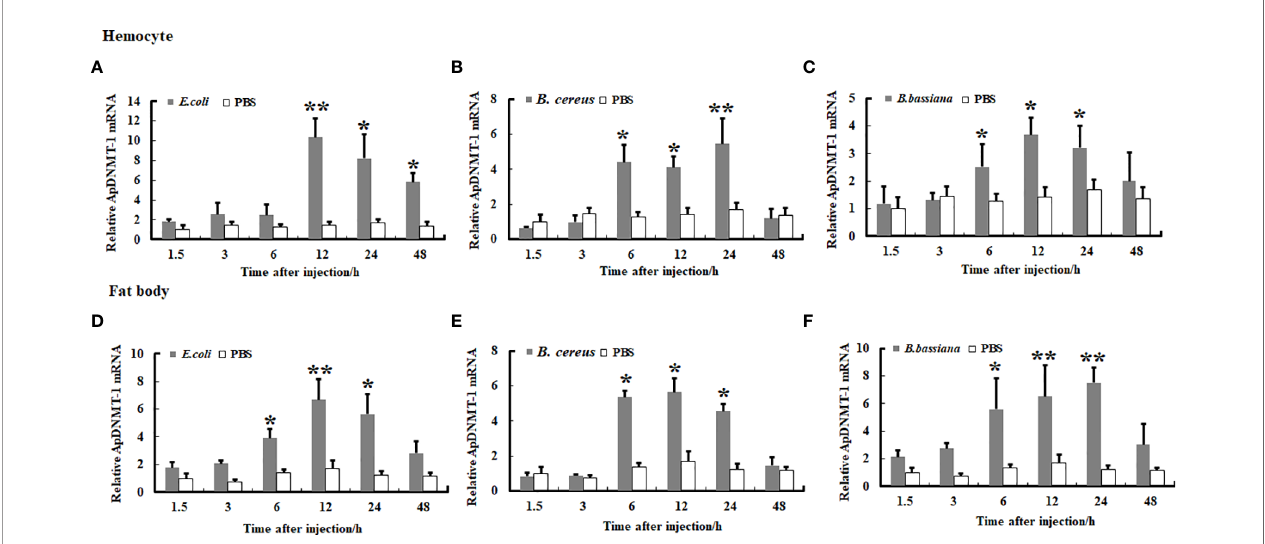
FIGURE 6 | Expression pro fi le of ApDNMT-1 in hemocyte and fat body following microbial challenge. (A) Expression pro fi le following E. coli challenge in hemocyte, (B) Expression pro fi le following B. cereus challenge in hemocyte, (C) Expression pro fi le following B. bassiana challenge in hemocyte, (D) Expression pro fi le following E. coli challenge in the fat body, (E) Expression pro fi le following B . cereus challenge in the fat body, (F) Expression pro fi le following B. bassiana challenge in the fat body. PBS was injected as the control. Bars show mean ± S.E. (n = 3), and asterisks indicate signi fi cant differences (* p < 0.05, ** p < 0.01).